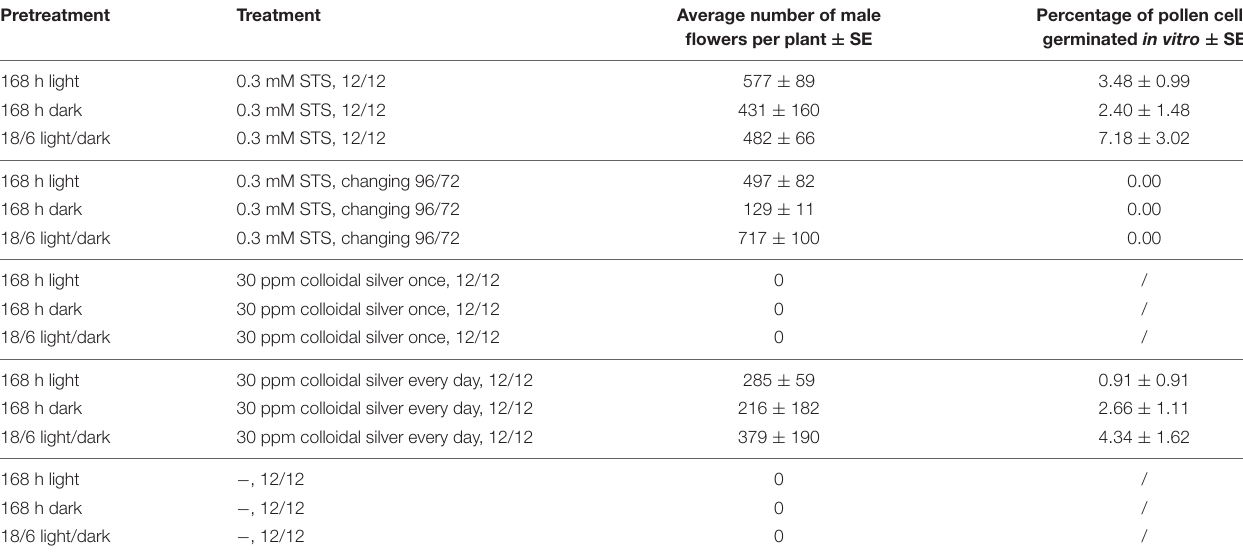
TABLE 5 | Number of male flowers per plant and number of germinated pollen cells in vitro after the induction of male flowering on female plants of MX-CBD-707. Pretreatment Treatment Average number of male